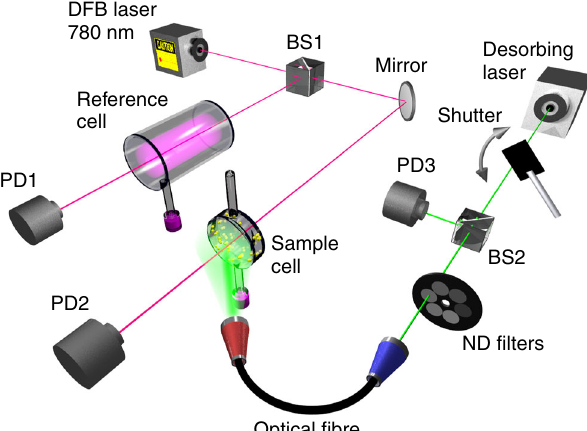
Fig. 2 Schematic diagram of the experimental setup. DFB distributed feedback laser, BS1 and BS2 beam splitters, PD1, PD2, and PD3 photo detectors, ND fi lters neutral density fi lters. The DFB laser current is externally modulated to scan the D 2 line of